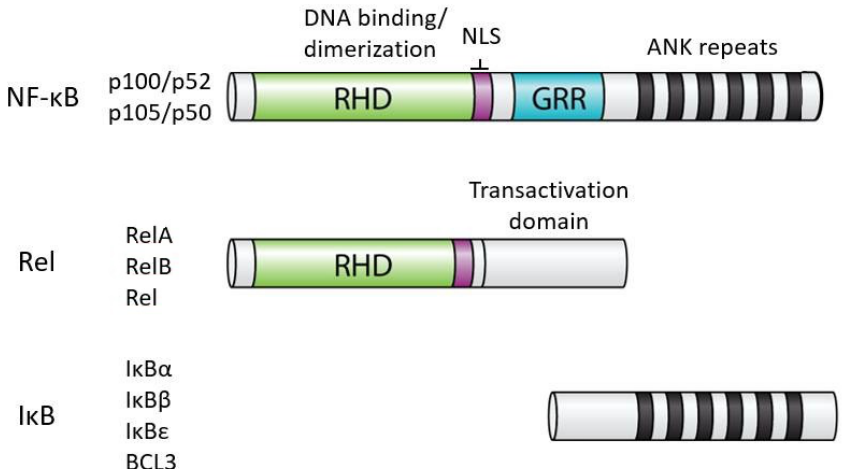
Figure 1. General structures of NF-κB and IκB proteins. Shown are the general structures of human NF-κB and Rel proteins, as well as IκB proteins (i.e., IκBα, IκBβ, IκBε, BCL3). RHD, Rel homology domain; NLS, nuclear localization sequence; GRR, glycine-rich region; ANK, ankyrin repeats (black bars). The details of the indicated protein domains are described in the text.